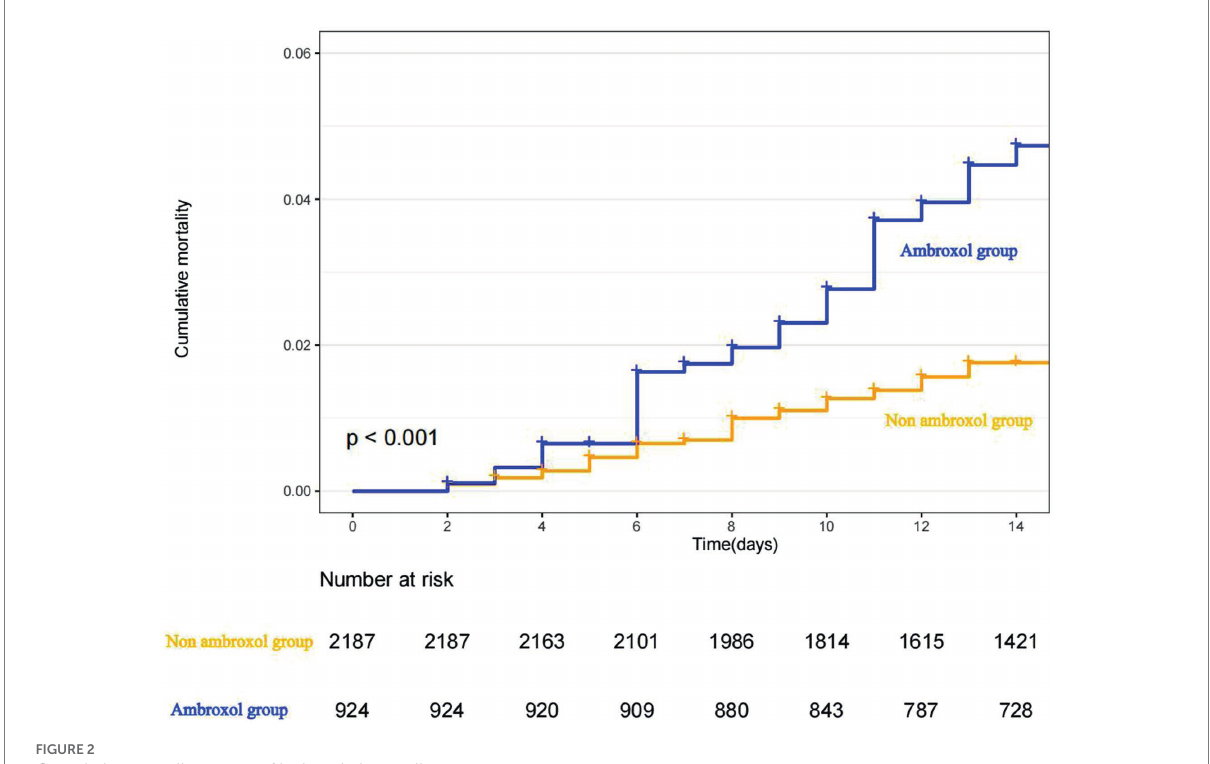
FIGURE 2 Cumulative mortality curves of in-hospital mortality.